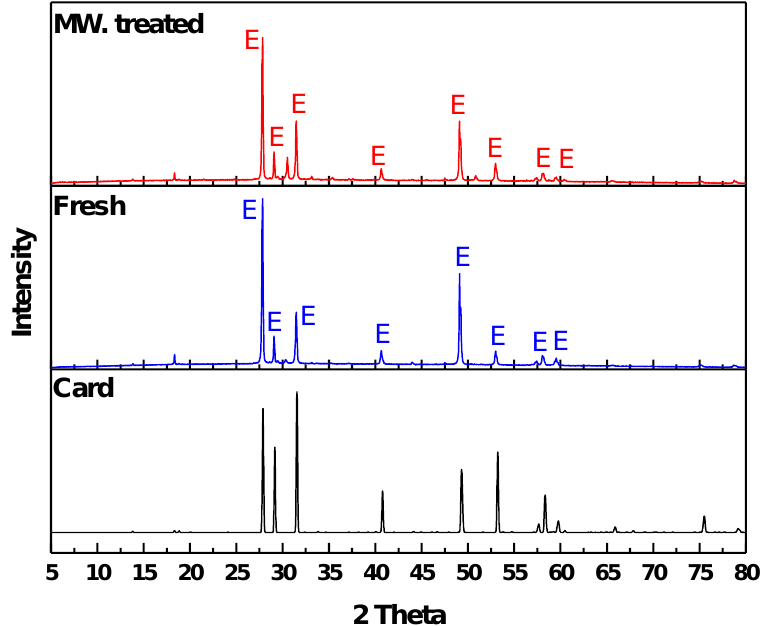
Figure 1. XRD patterns for fresh and microwave treated enargite. E denotes enargite.